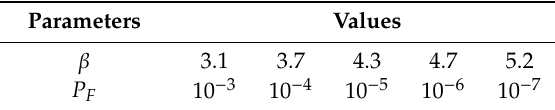
Table 2. Typical values of β and P F .